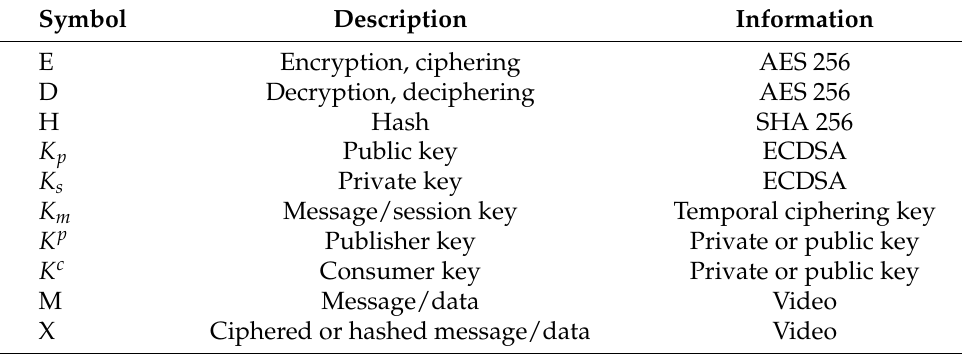
Table 1. Security symbols in the vehicular content